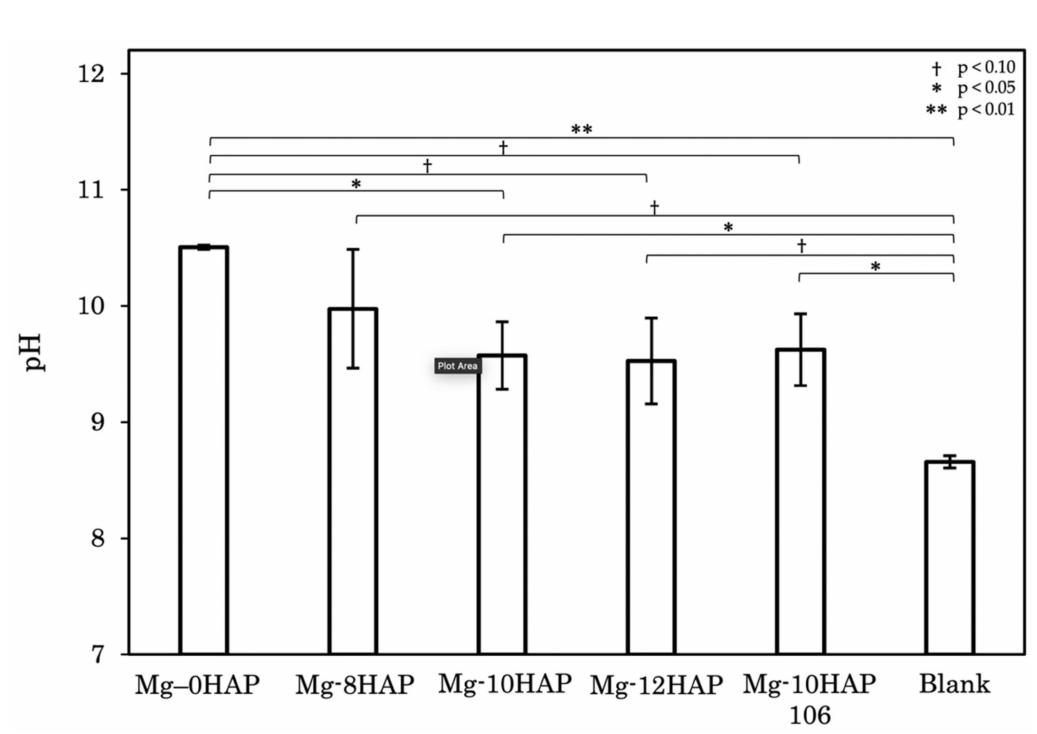
Figure 11. pH of the solution after the immersion test for 5 days. Control which had no samples inside was measured as a